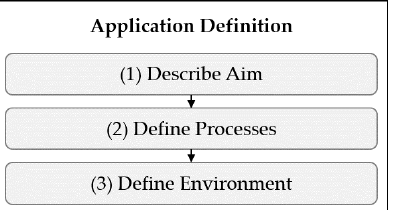
Figure 4. Functions of the module Application Definition